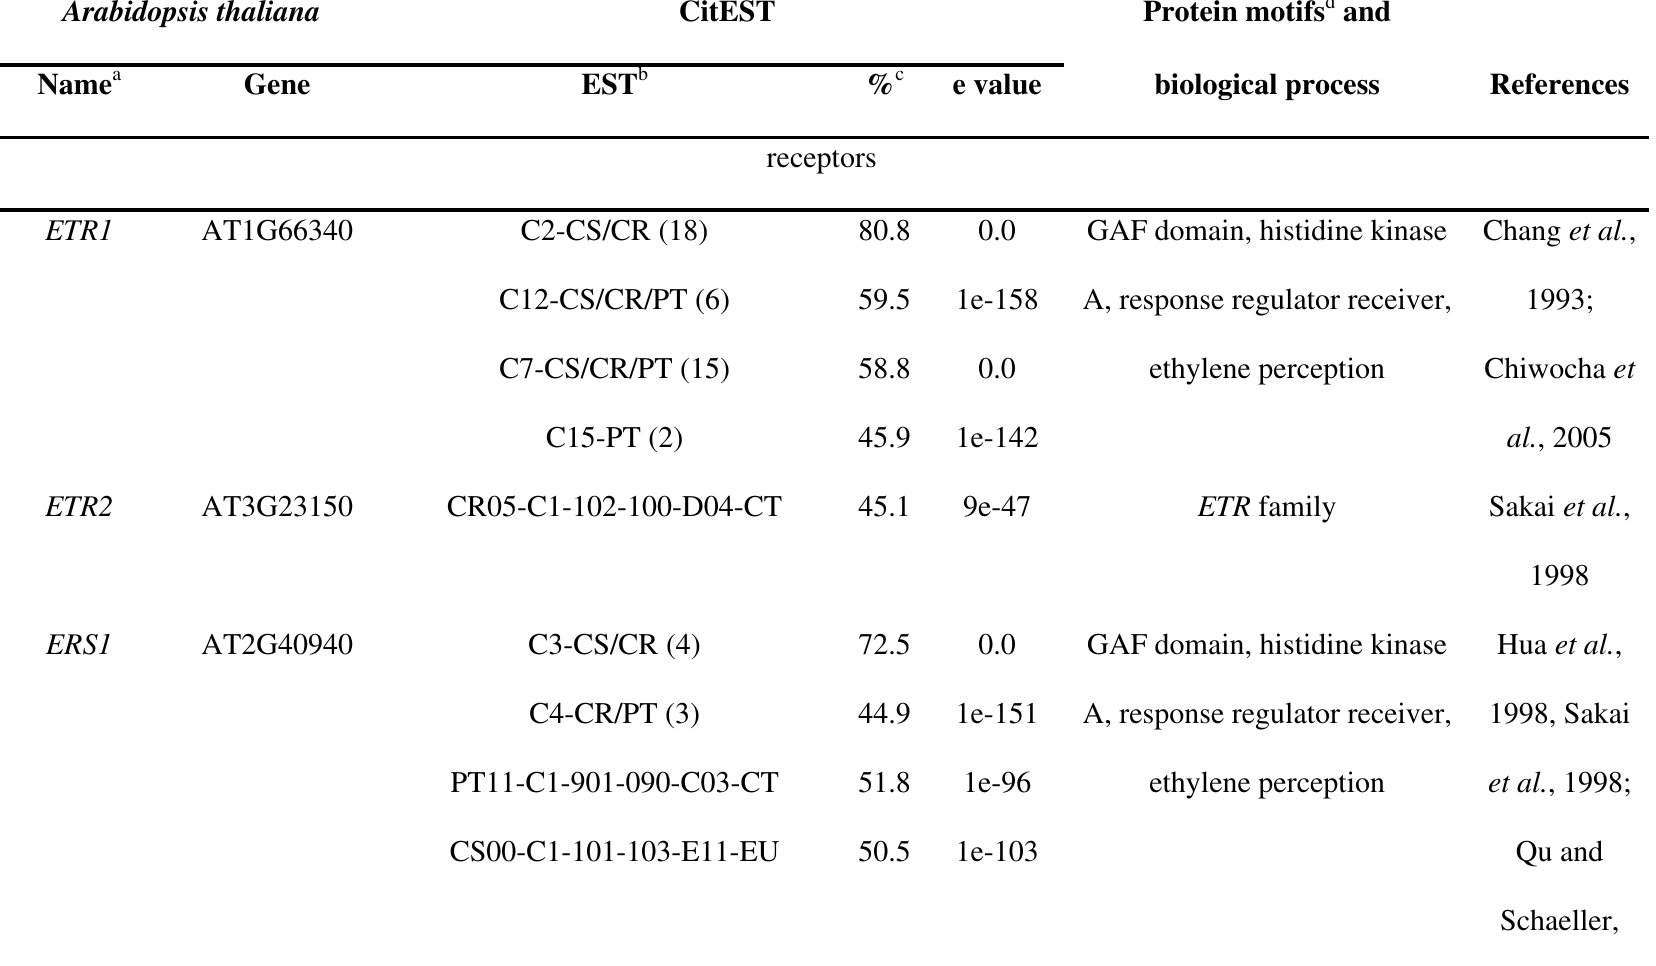
Table S9 – Citrus ESTs with homology to genes involved in ethylene signal transduction in Arabidopsis thaliana